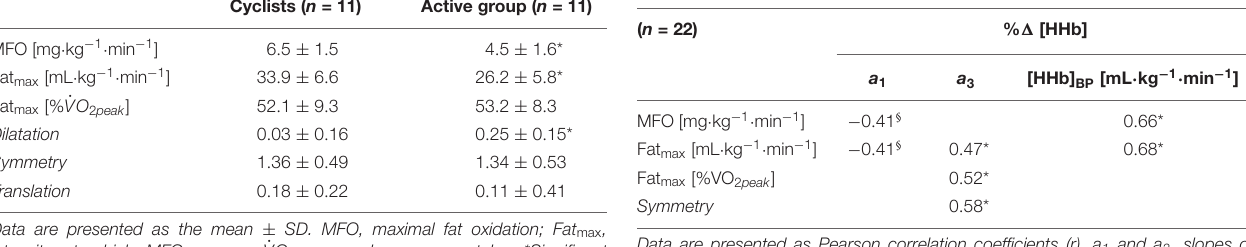
TABLE 4 | Correlations between fat oxidation kinetics and muscle deoxygenation kinetics parameters.